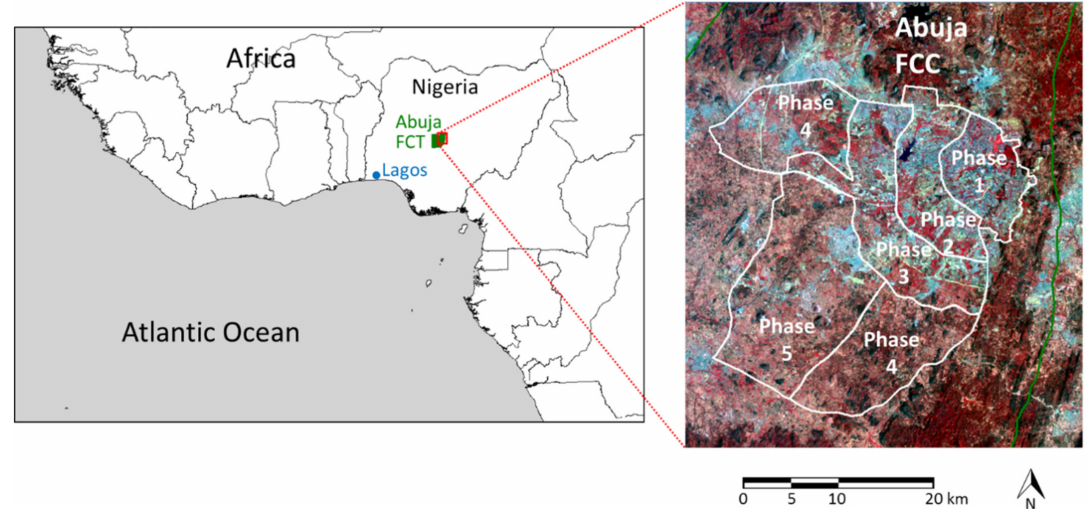
Figure 1. Study area showing the extent of Abuja Federal capital territory (FCT) on the left, with an inset of Abuja Federal capital city (FCC) and its phase boundaries on the right. The FCC footprint is overlaid on a false color composite Landsat operational land imager (OLI) image. (FCC map adapted from data supplied by the Abuja Geographic Information System Agency, Federal Capital Development Authority and Nigeria Space Research and Development Agency; Landsat OLI image supplied by US Geological